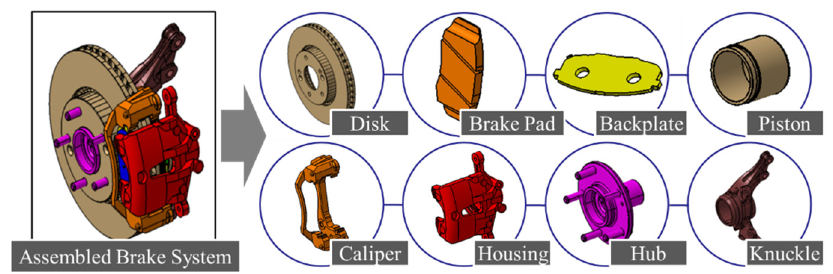
Figure 8. Configuration of assembled brake system and subparts.